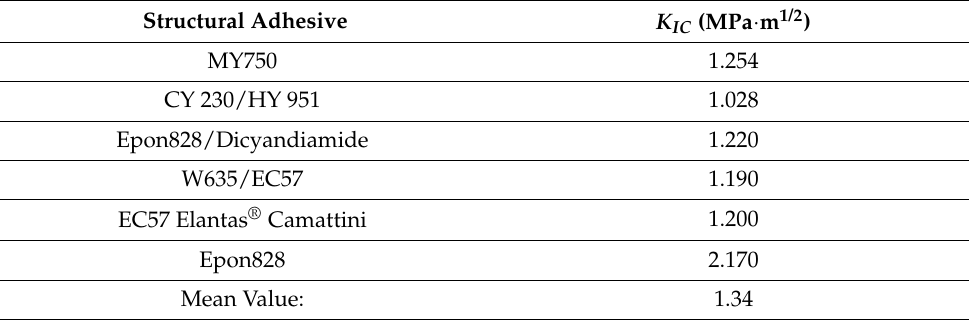
Table 9. Fracture toughness of structural adhesives.